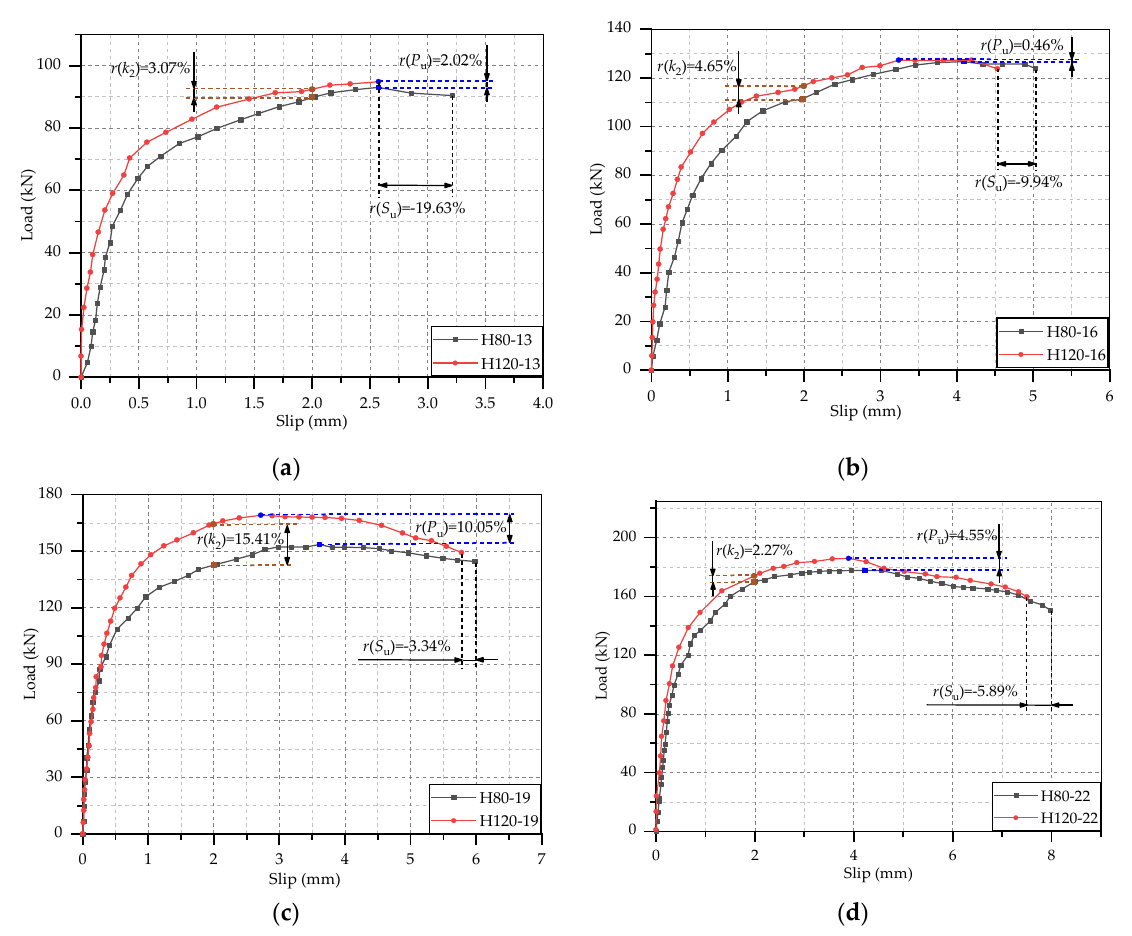
Figure 7. Effect of stud height: ( a ) d = 13 mm; ( b ) d = 16 mm; ( c ) d = 19 mm; ( d ) d = 22 mm.